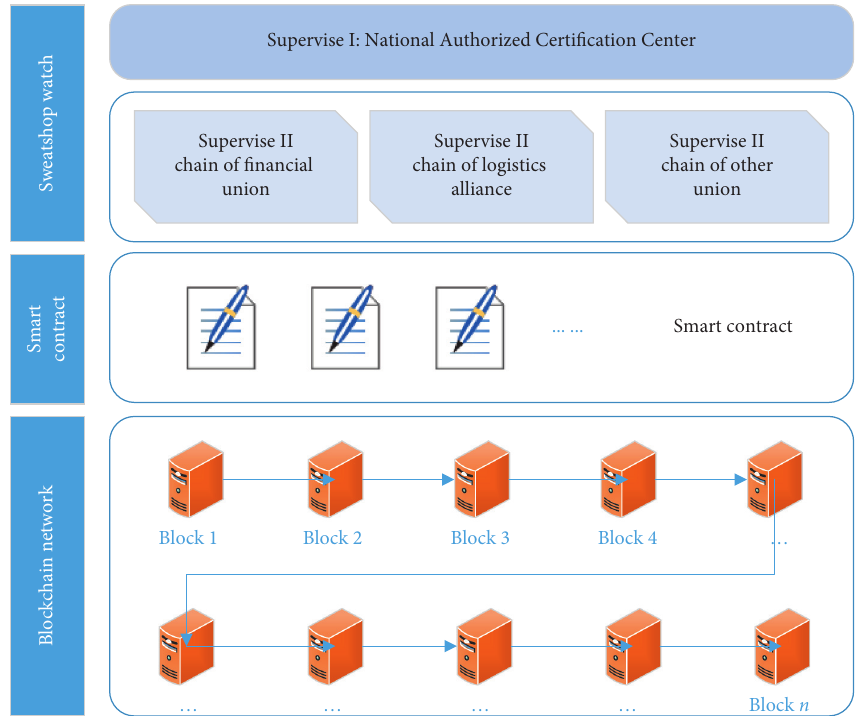
Figure 3: Hierarchical and multitiered intelligent logistics regulatory framework.